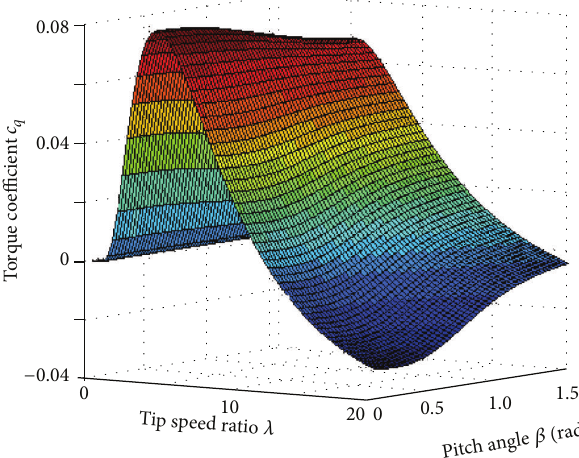
Figure 5: Typical torque coefficient